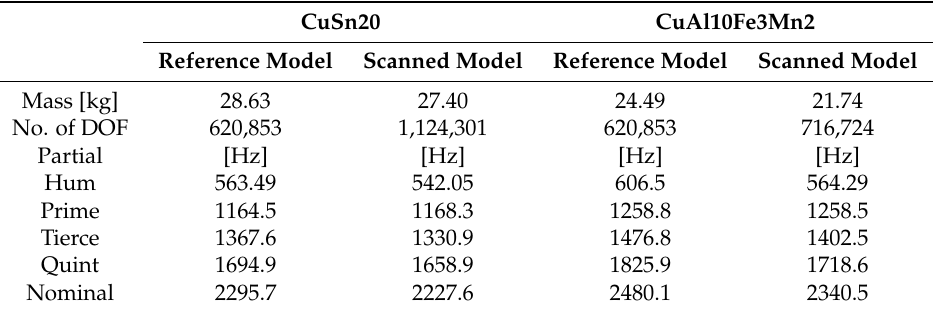
Figure 10. Modal shapes for the musical partials of an analyzed bell predicted by FEM. Table 4. Numerical partial